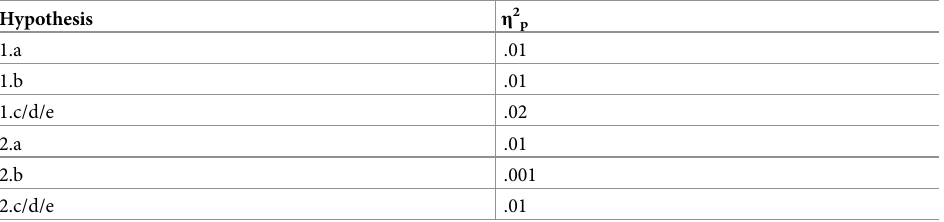
Table 1. Minimum reliably detectable effect sizes for hypotheses 1 and